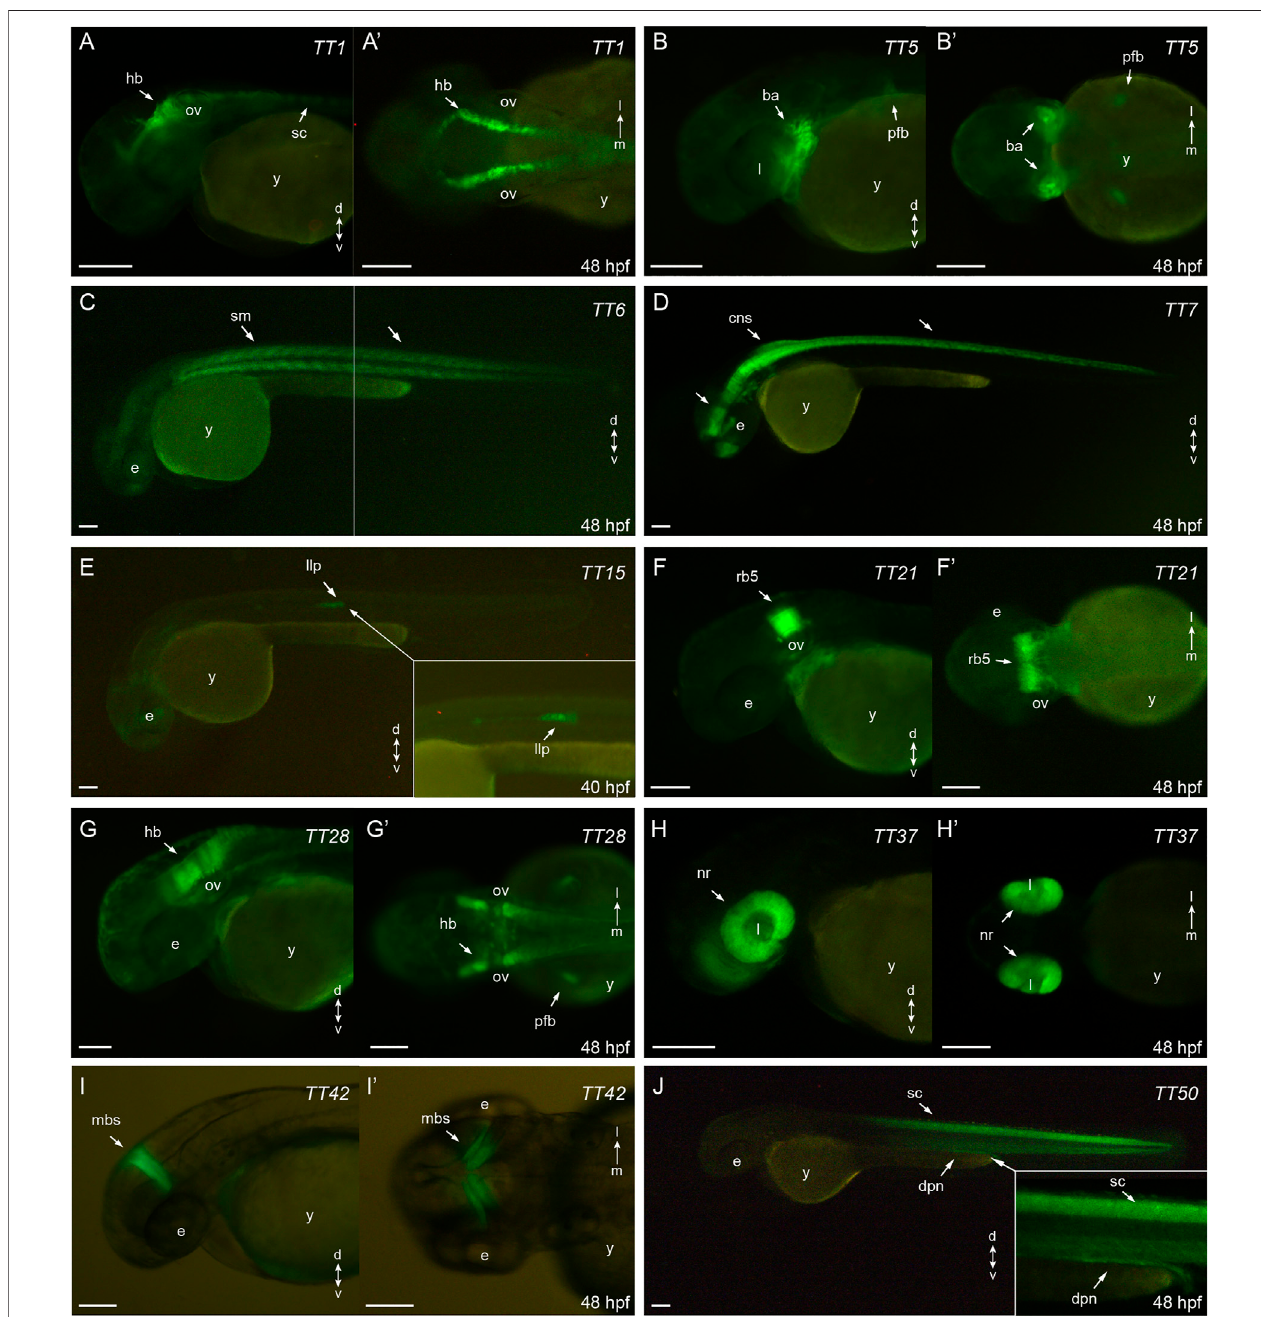
FIGURE 2 | eGFP-rpl10a expression patterns : (A,A 9 ) : TT1, hindbrain and spinal chord (lateral and dorsal, respectively); (B,B 9 ) : TT5, jaw, brachial arches and pectoral fi n buds (lateral and ventral, respectively); (C) : TT6, skeletal muscles (lateral); (D) : TT7, central nervous system (lateral); (E) : TT15, lateral line system (lateral); (F, F 9 ) :TT21,rhombomere5(lateralanddorsal,respectively); (G,G 9 ) :TT28,hindbrainandpectoral fi nbuds(lateralanddorsal,respectively); (H,H 9 ) :TT37,retina(lateraland ventral, respectively); (I,I 9 ) : TT42, midbrain stripe (lateral and dorsal, respectively); (J) : TT50, spinal cord and pronephros (lateral). ba, branchial arches; cns, central nervous system; dpn, distal pronephros; e, eye; hb, hindbrain; l, lens; llp, lateral line primordium; mbs, midbrain stripe; nr, neural retina; ov, otic vesicle; pfb, pectoral fi n buds; rb5, rhombomere 5; sc, spinal cord, sm, skeletal muscles; y, yolk. Scale bar, 100 µm.